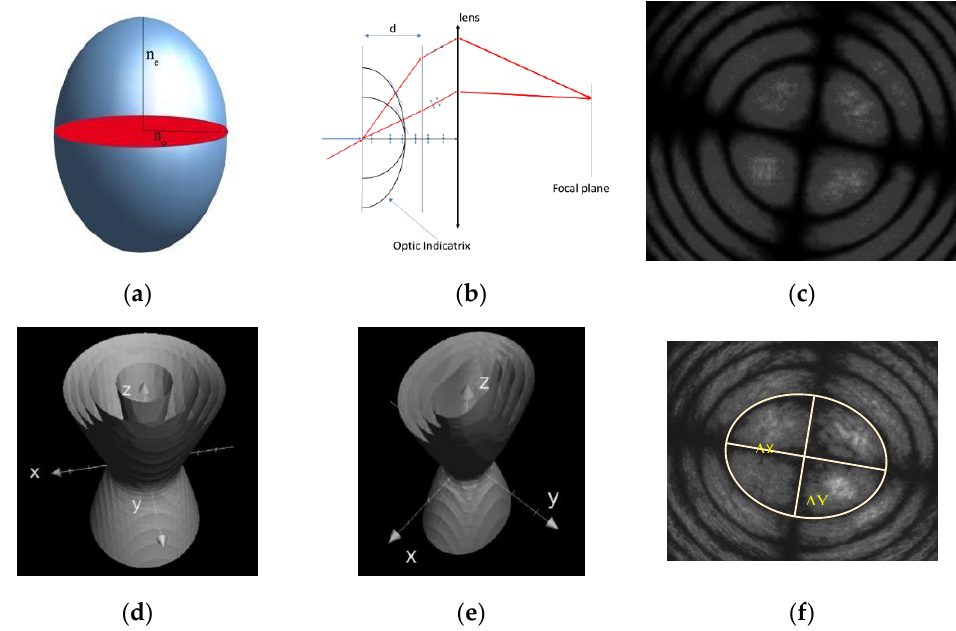
Figure 1. ( a ) The optic indicatrix of a uniaxial crystal. The semi-axes of the ellipsoid (prolate or oblate) are the refraction indices. The two refraction indices (n o and n e ) are shown. In biaxial crystals there are three refraction indices as the optic indicatrix is a general ellipsoid. ( b ) A 2d scheme of the birefringent phenomenon under which the light goes crossing a birefringent sample with thickness d; the double-arrowed lines and the dots represent two orthogonal polarizations of light. ( c ) Conoscopic fringe pattern observing the sample along its optic axis. ( d ) A simulation of the Bertin iso-delay surfaces; the optic axis is the z axis. ( e ) Simulation of Bertin surfaces for a stressed uniaxial crystal and/or a naturally biaxial crystal, where the z axis is the optic axes bisector. ( f ) The fringe pattern obtained by observing a stressed uniaxial crystal or, possibly, a biaxial crystal observed along the acute bisector of the optic axes (the z axis in ( e )) (used with permission from Copyright Clearance Center/AIP Publishing, [21]).